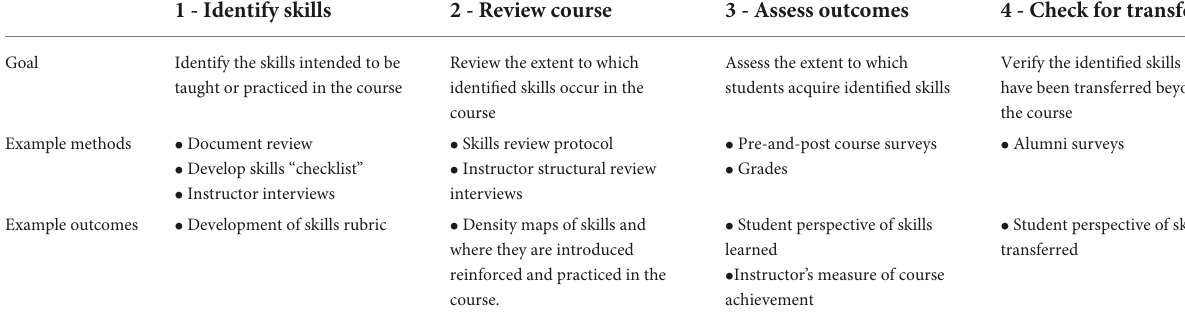
TABLE 1 Course assessment for skills